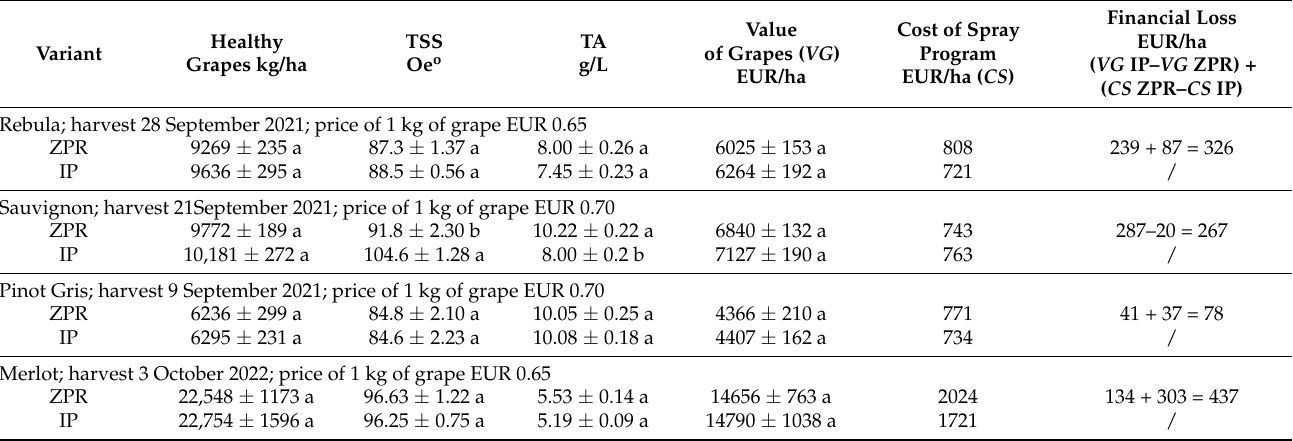
Table 7. Yield and must parameters (mean ± SE) (TSS—total soluble solids, TA—total acidity) for two grape protection systems (ZPR—0-pesticide residue protection; IP—integrated protection) in four grape varieties.